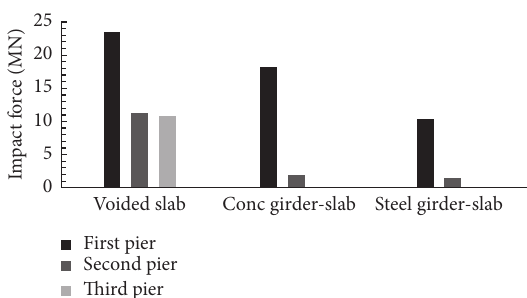
Figure 11: Impacting force on pier of the bridge with different superstructure